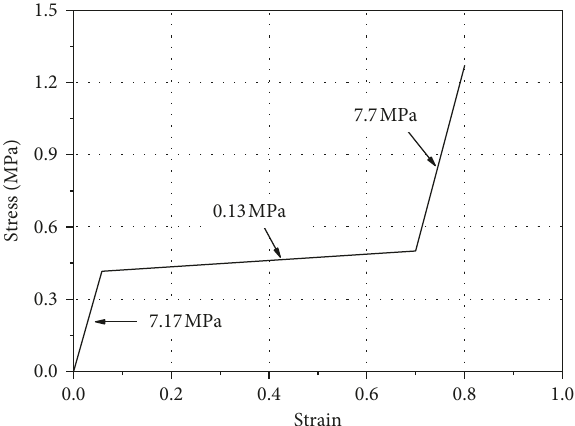
Figure 3: The trilinear equivalent stress-strain curve of the PU foam